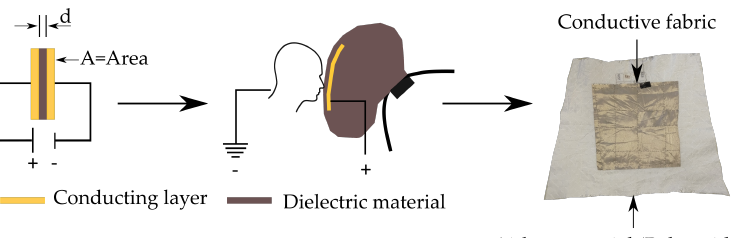
Figure 2. Sensor concept.